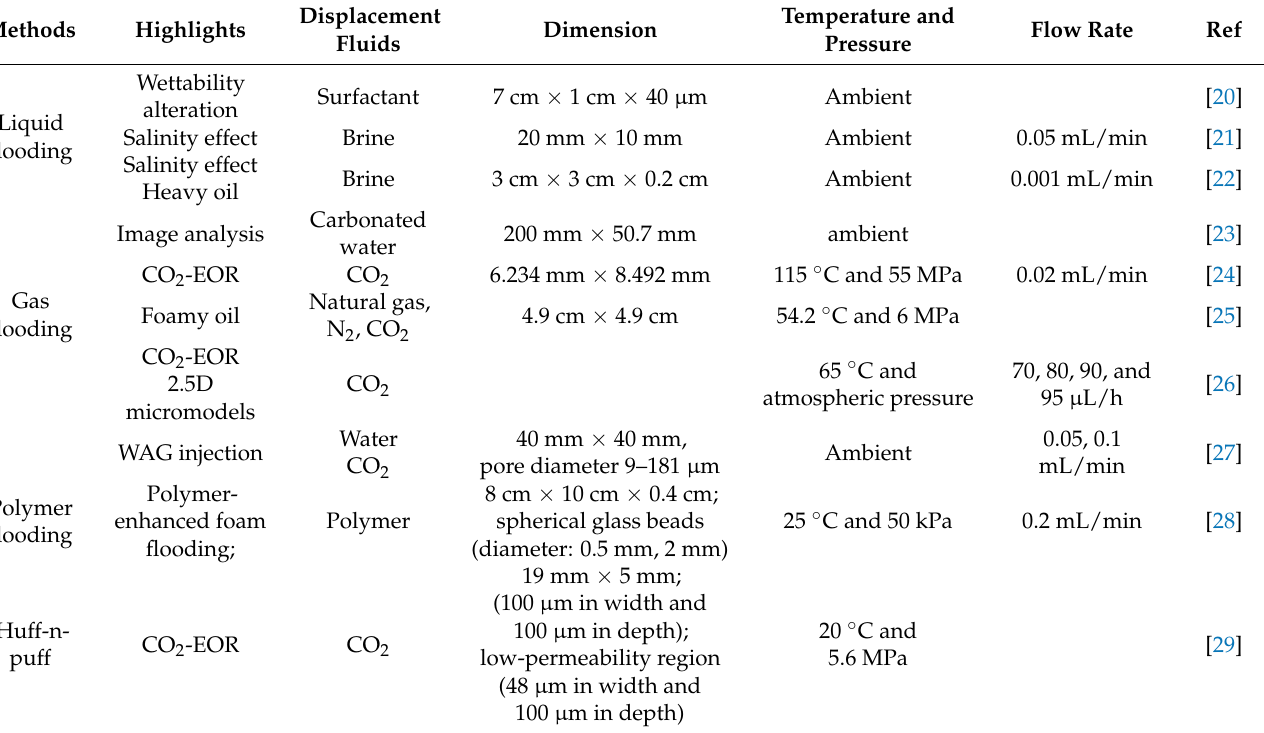
Table 1. Application of microscopic model in EOR